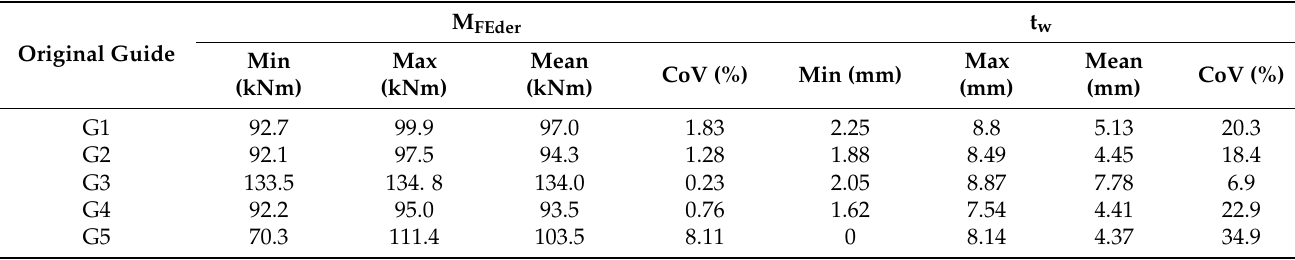
Table 4. Statistics of ultimate moment capacity and web thicknesses of beams derived by original guide segmentation and mirroring.